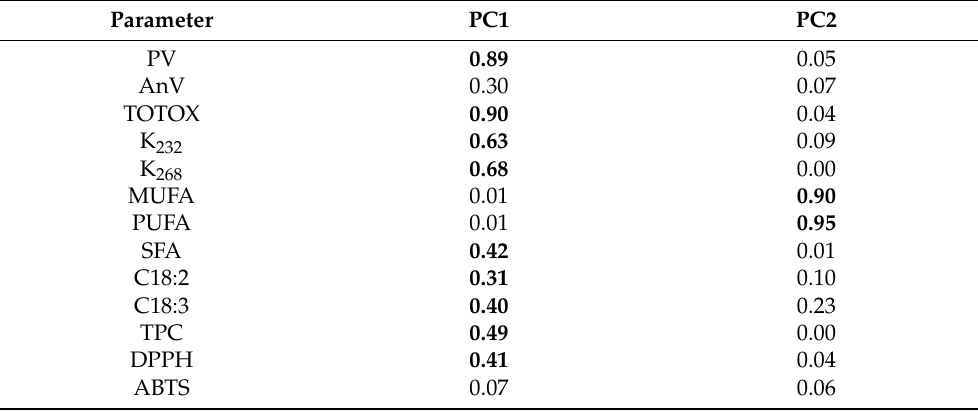
Table 7. Principal component analysis (PCA) factor loadings for the quality factors of analysed